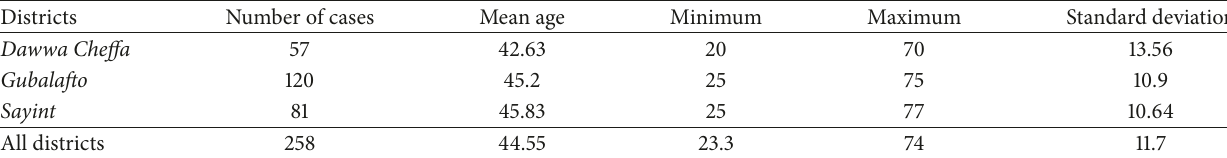
Table 1: Age of the household head (years) by